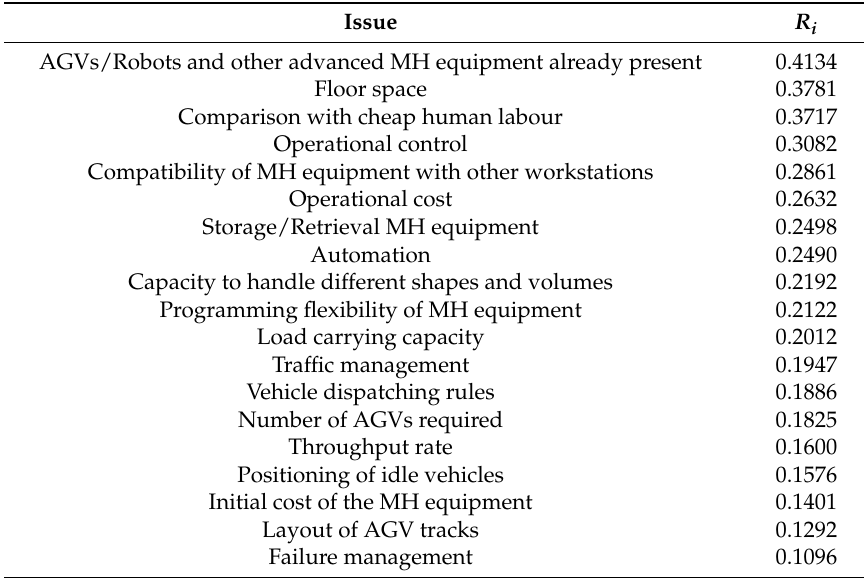
Table 26. Ranking the issues from largest to smallest